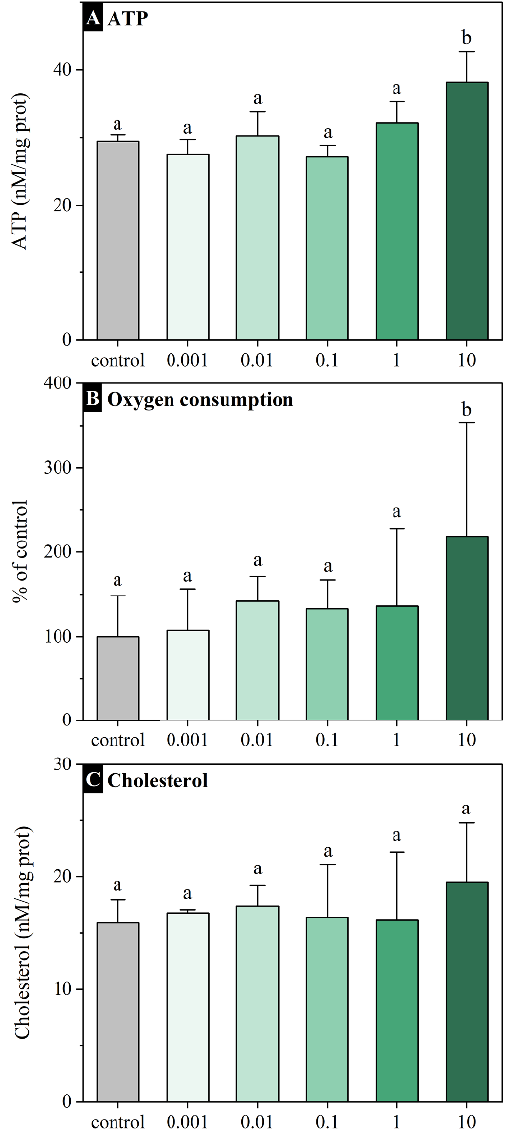
Figure 3. The energy consumption and membrane function-related biomarker changes in medaka after exposure to nanoplastics. ( A ) Adenosine 5’-triphosphate (ATP) content, ( B ) oxygen (O 2 ) con- sumption, and ( C ) cholesterol content. Abundance values are expressed as mean ± standard deviation ( n = 3 replicates per treatment). Treatments sharing the same lowercase letters are statistically similar to each other (one-way ANOVA, Tukey’s post hoc, p < 0.05).